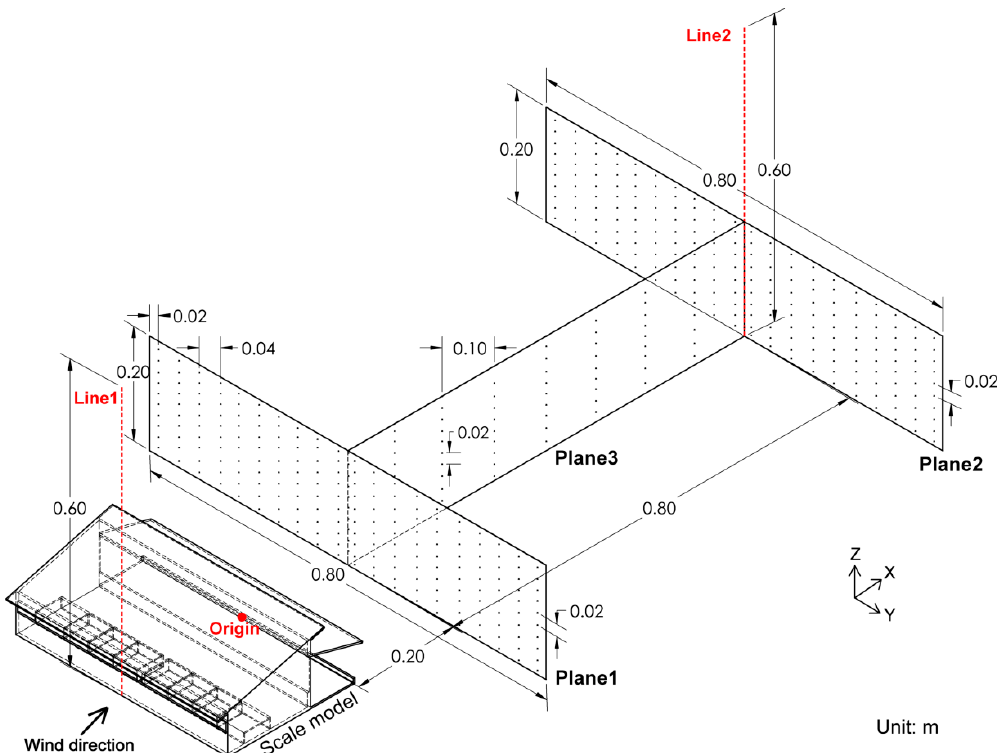
Figure 3. Isometric view of the scale model and air velocity measurement positions. Lines 1 and 2 indicate vertical lines for wind profile measurements. The black dots at Planes 1–3 represent actual velocity measurement positions downwind the building. X , Y and Z represent axes of the coordinate system. The red dot represents the origin of the coordinate system.